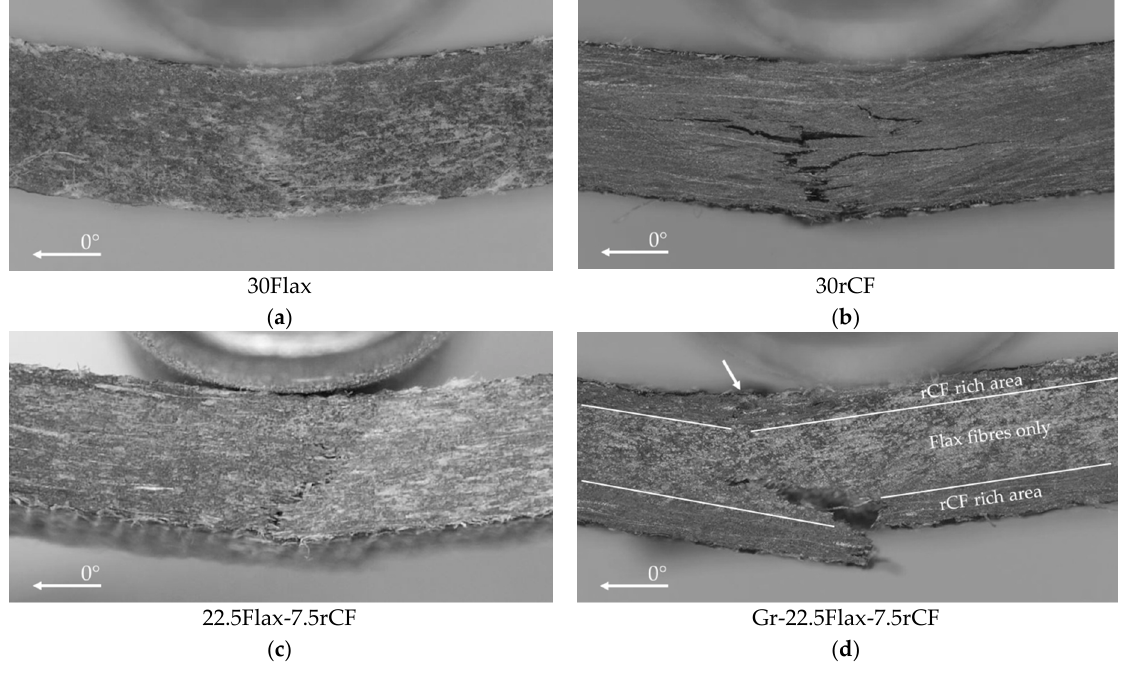
Figure 9. Fracture patterns after completion of the three-point bending tests in the 0° laminate test direction. The arrow in ( d ) marks the first area of compressive failure in the laminate with rCF concentration in the outer layers while the final failure occurred on the tensile side. The rCF rich areas in the laminate Gr-22.5Flax-7.5rCF ( d ) are marked. All other samples ( a – c ) failed on the tensile side without any visible compression damage. All images were extracted from video footage taken during testing with Panasonic GH-5 and Sigma 105 mm/2.8 DG Macro HSM lens mounted on a tripod.